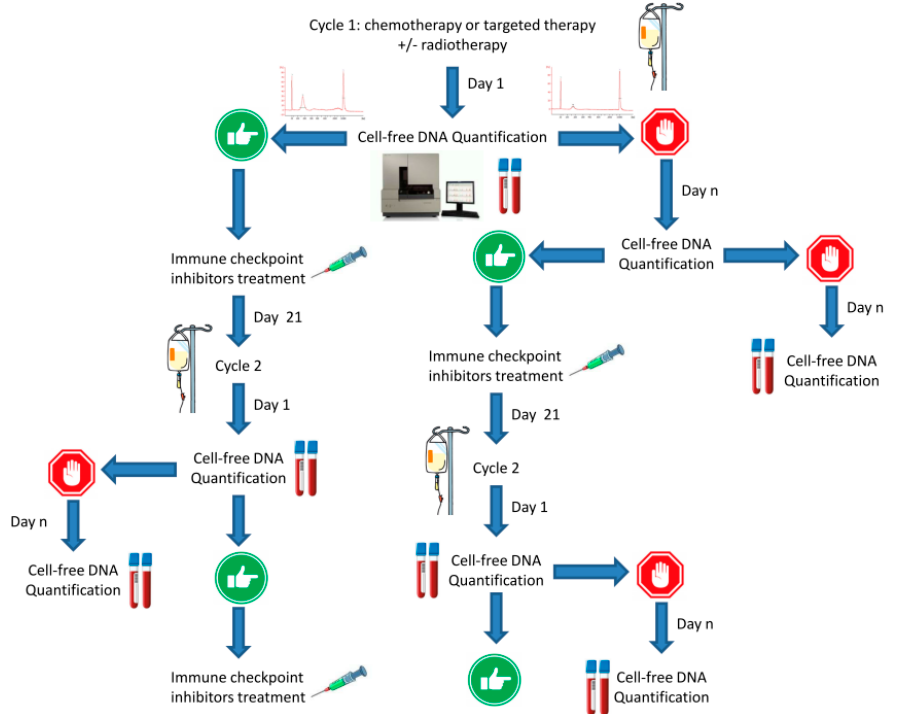
Figure 4. Proposed strategy for refining combinatorial immunotherapy. After that standard treatment is given, longitudinal monitoring of cell-free DNA helps to determine the best timing for further administering immune checkpoint inhibitors. Rather than pre-defined dosing, longitudinal monitoring allows customized treatment throughout time.